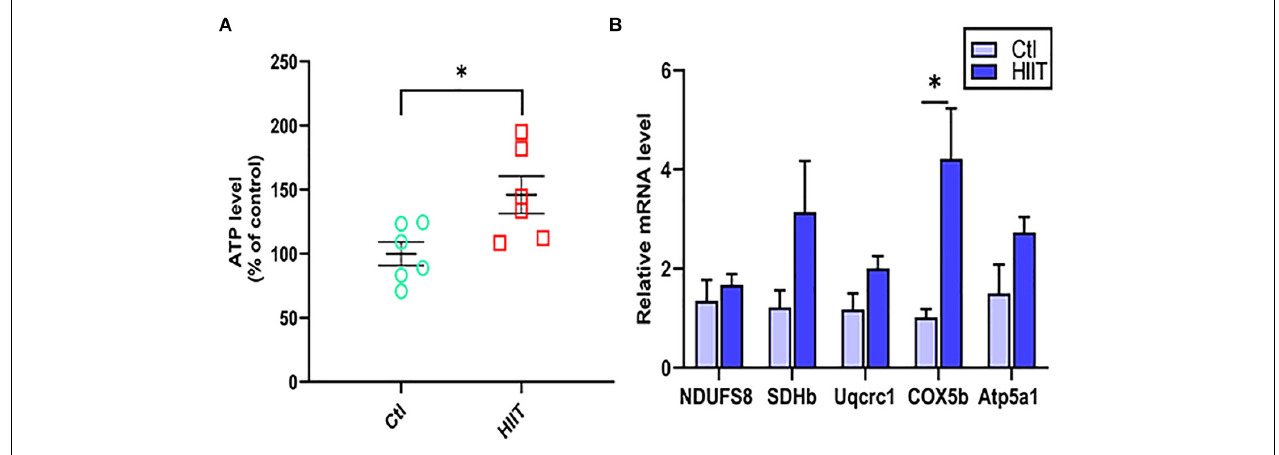
FIGURE 3 | The effects of HIIT on hippocampal mitochondrial function. The level of ATP was detected by Luciferase and the oxidative phosphorylation (OXPHOS) related genes (NDUFS8, SDHb, Uqcrc1, COX5b, and Atp5a1) was detected by RT-PCR in mouse hippocampus. (A) The ATP level. (B) OXPHOS mRNA levels. The gapdh as the loading control. N = 6 mice per group. ∗ P ≤ 0.05 as compared with the Ctl group by unpaired Student’s t test. Values are expressed as mean ± standard error of the mean.